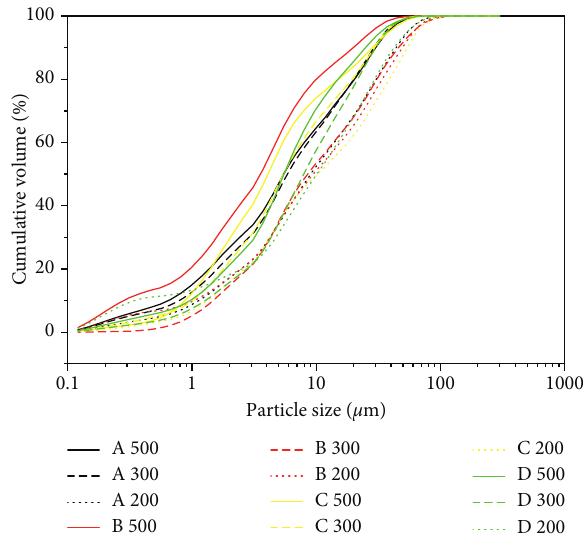
Figure 3: The particle size analysis curves of ore